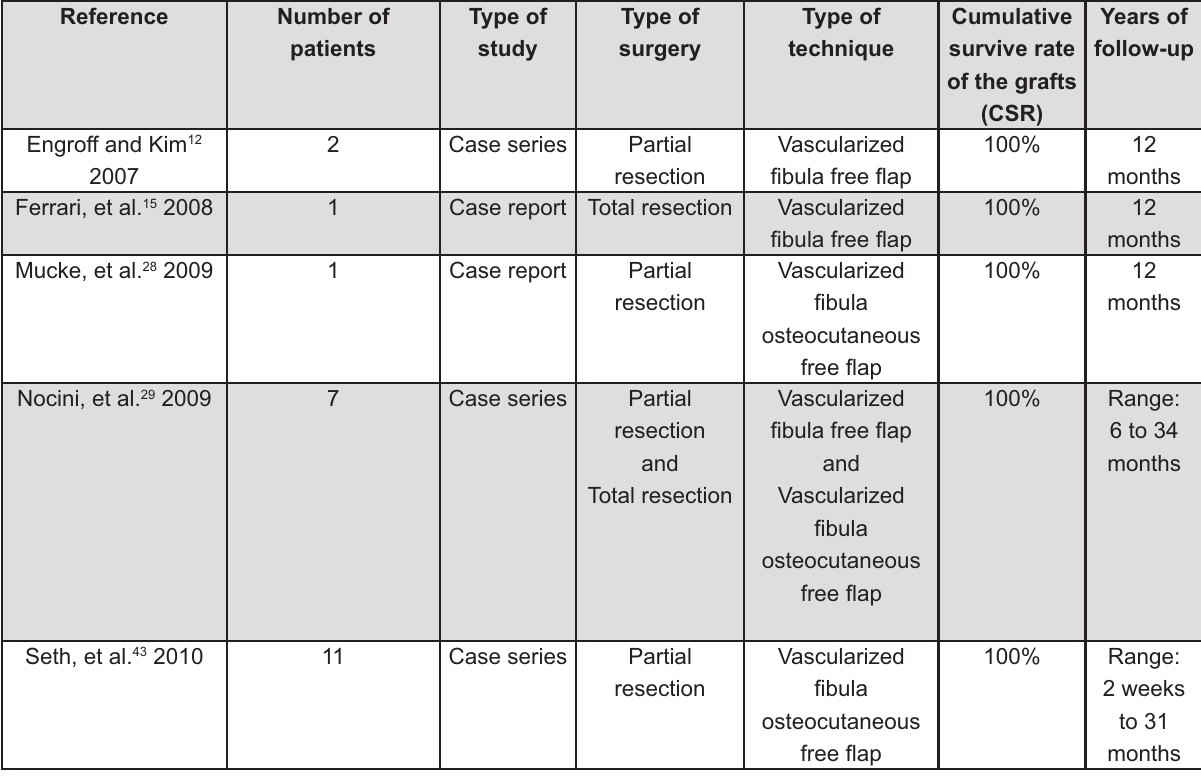
Figure 6- Studies retrieved from the review of the literature: analysis of type of surgery, type of graft used, cumulative survival rate of the grafts and years of